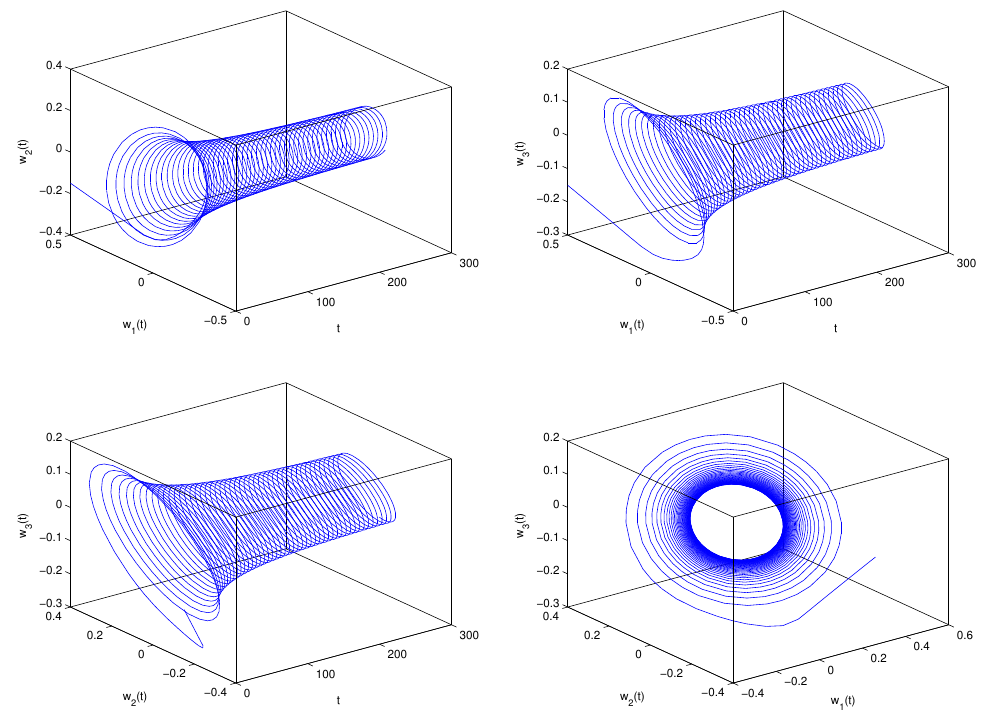
Figure 2. Computer simulation figures of system (95) with ρ = 0.7 > ρ 0 ≈ 0.6. The Hopf bifurcation arises in the vicinity of W 0 ( 0,0,0 ) when time t → ∞ .